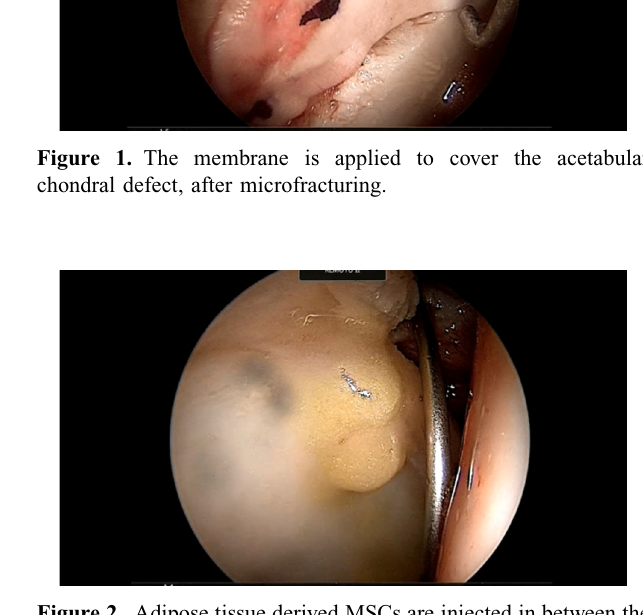
Figure 2. Adipose tissue derived MSCs are injected in between the fibrous chondral layer and the subchondral bone for the treatment of an acetabuar